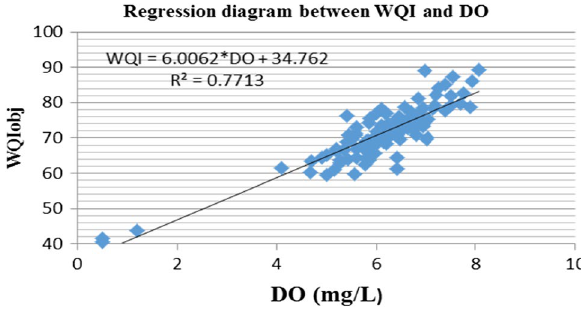
Fig. 3 Regression diagram between WQI from 35 sampling sites in